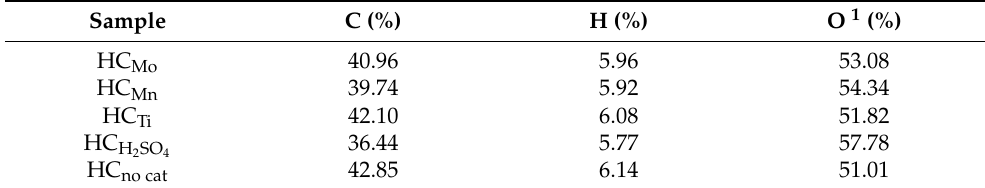
Table 3. Carbon, hydrogen, and oxygen contents in the hemicellulose